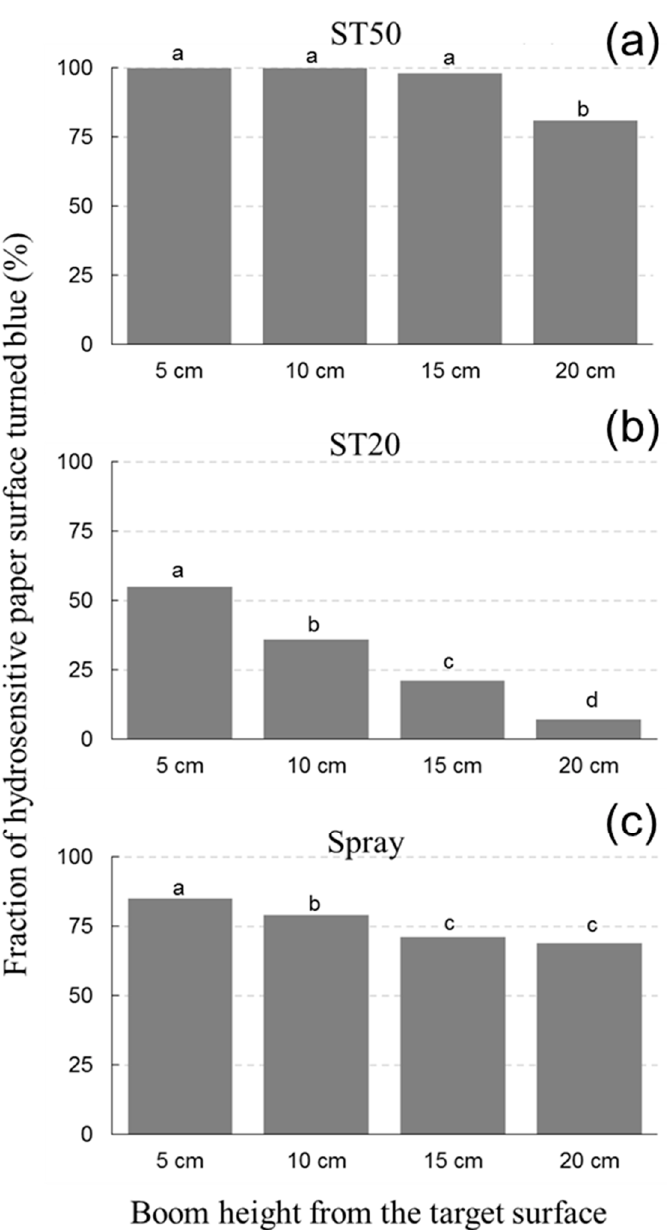
Figure 13. Percentage of hydrosensitive paper surface turned blue, and therefore reached by water, following treatment with the ST50 ( a ), ST20 ( b ), and Spray ( c ) systems at 5, 10, 15, and 20 cm from the supporting surface. Data are means of three replicates; different letters indicate statistically significant differences (Duncan’s test).